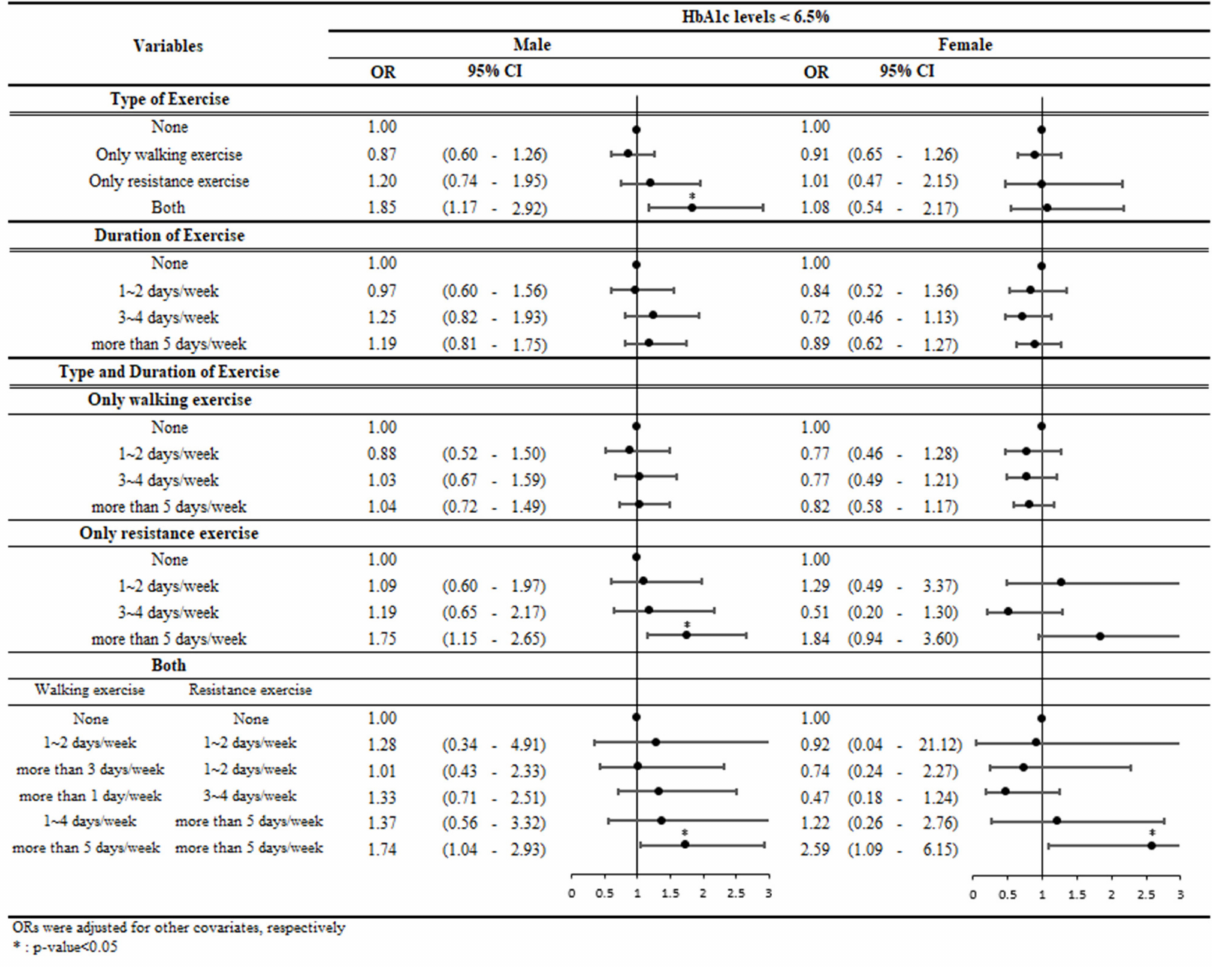
Figure 1. Results of subgroup analysis stratified by the type and duration of physical exercise. Abbreviations: HbA1c, glycated hemoglobin; OR, odds ratio; CI, confidence